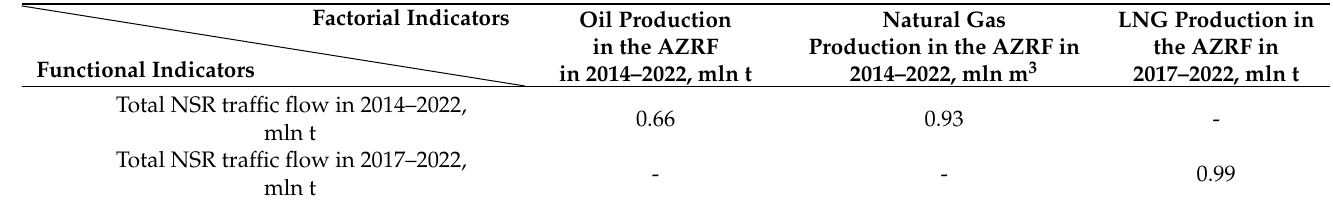
Table 3. Pair correlation coefficients between the NSR traffic flow and the production of hydrocarbons in the Arctic zone of the Russian